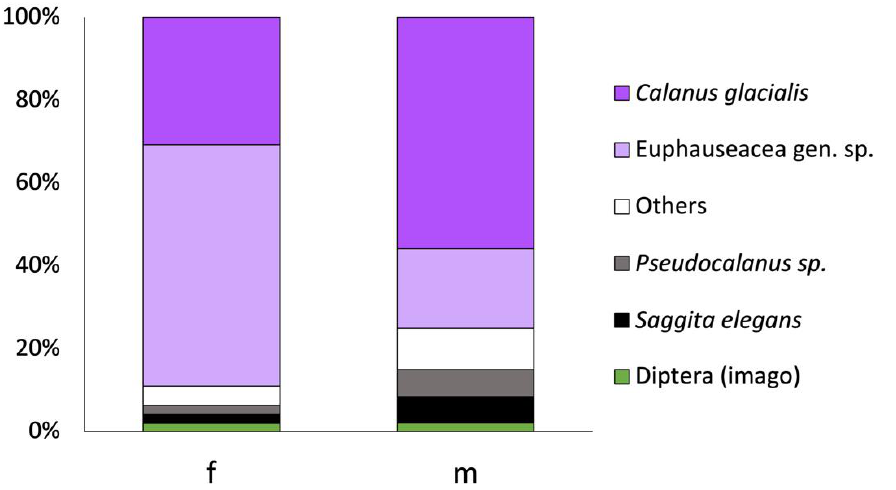
Figure 3. Stomach contents of female (F) and male (M) threespine stickleback at the offshore site CIE at the beginning of spawning period.